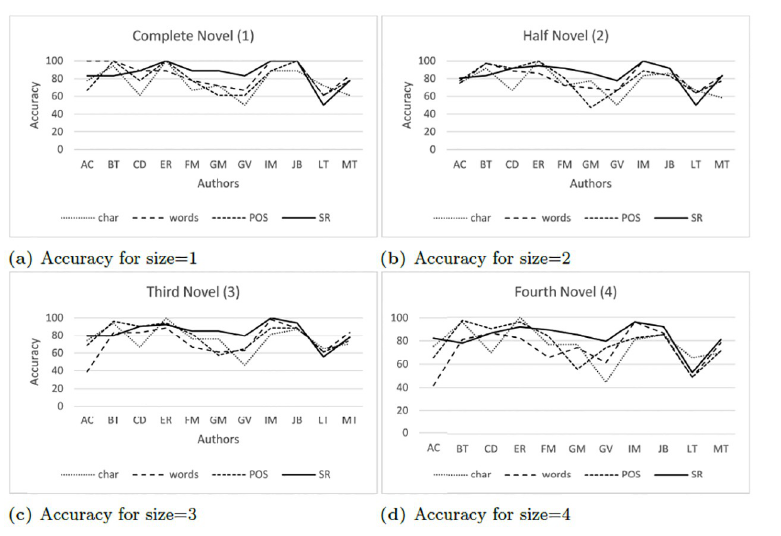
Fig 9. Accuracy (100%) obtained for different